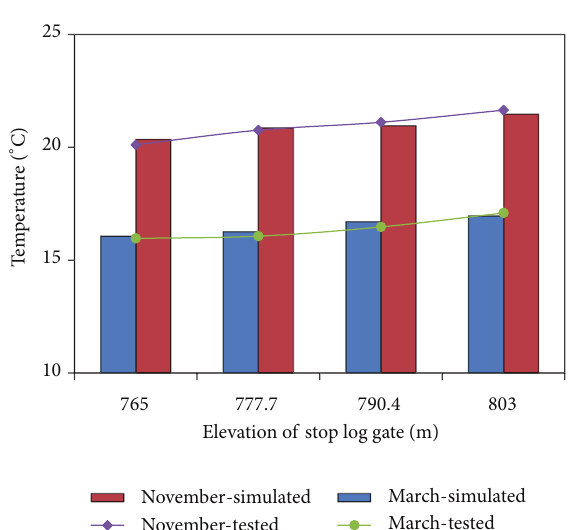
Figure 4: Comparison between the simulated and test values.